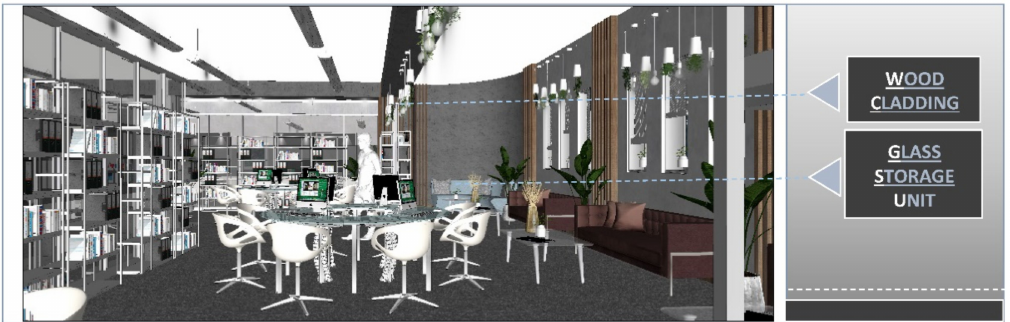
Figure 19. The interior design shows the glass partition, book storage units, and interior paths.